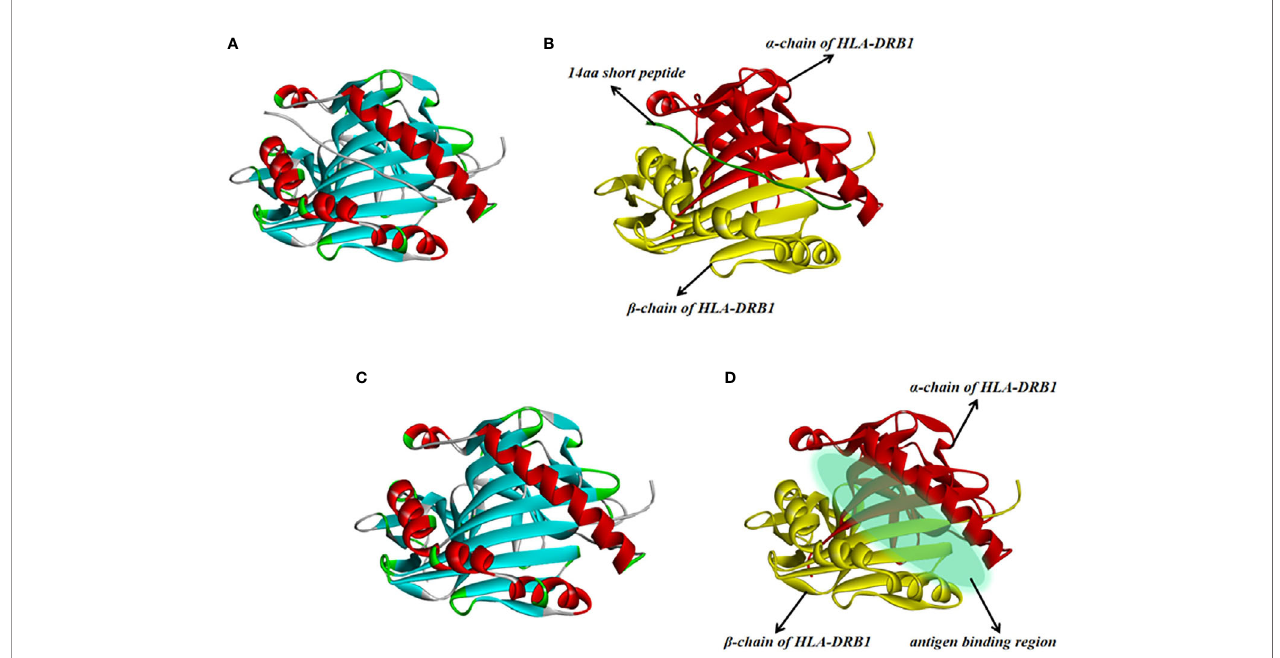
FIGURE 2 | The crystalline structure of HLA-DRB1. The (A, C) were general view, the (B, D) were speci fi c view in Figure 2 . According to the fi gure, the region between the two a -helices is the antigen peptide binding region of HLA-DRB1. (For understanding the reference color in remark of the fi gure clearly, please readers refer to the web version of this